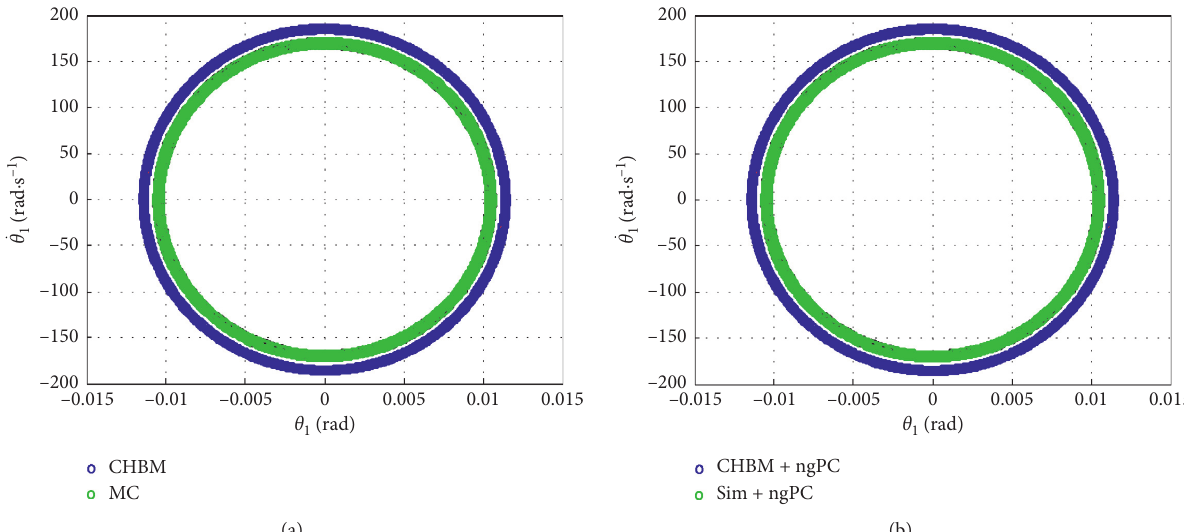
Figure 3: Dispersion of limit cycles ( μ � uncertain, μ